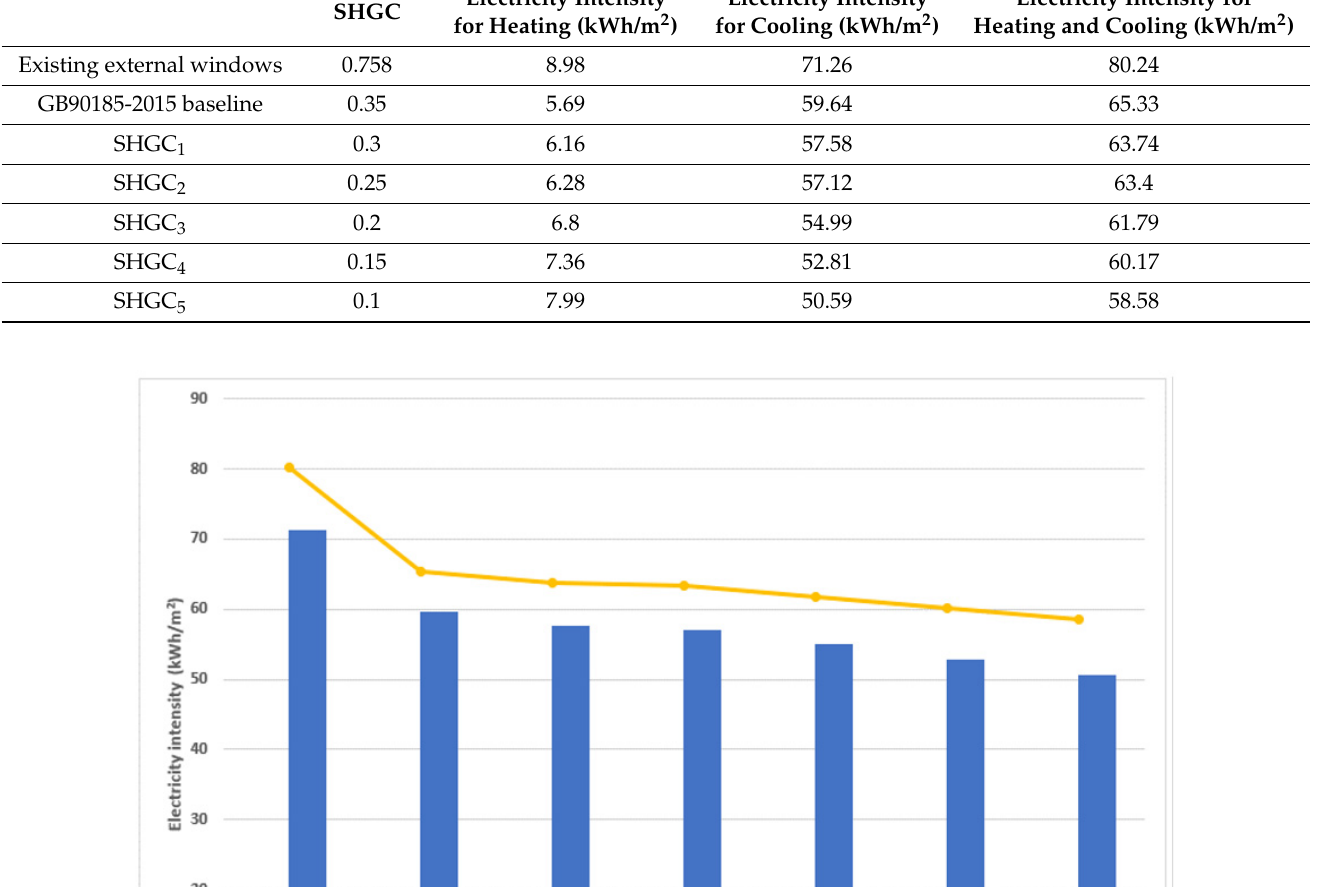
Table 9. Simulation results of different U-values for window energy retrofitting.